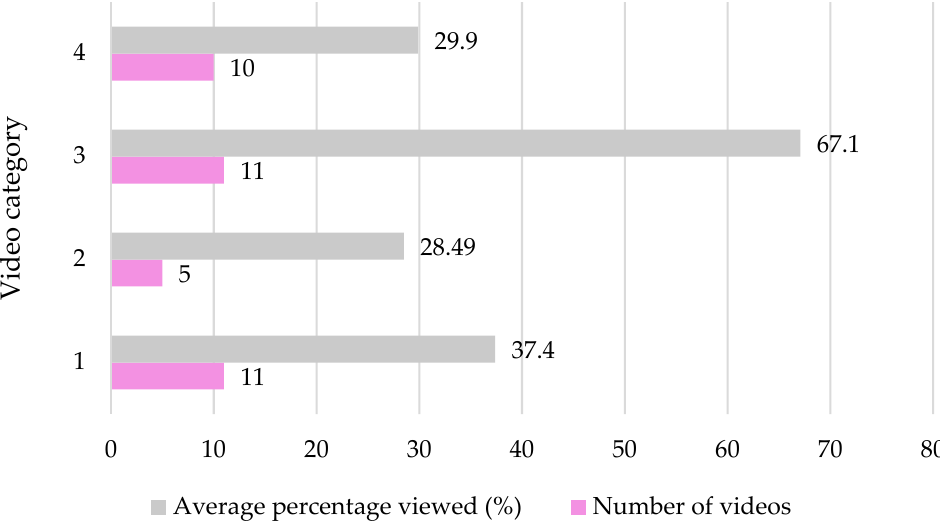
Figure 3. Average percentage of views and number of videos by video category.